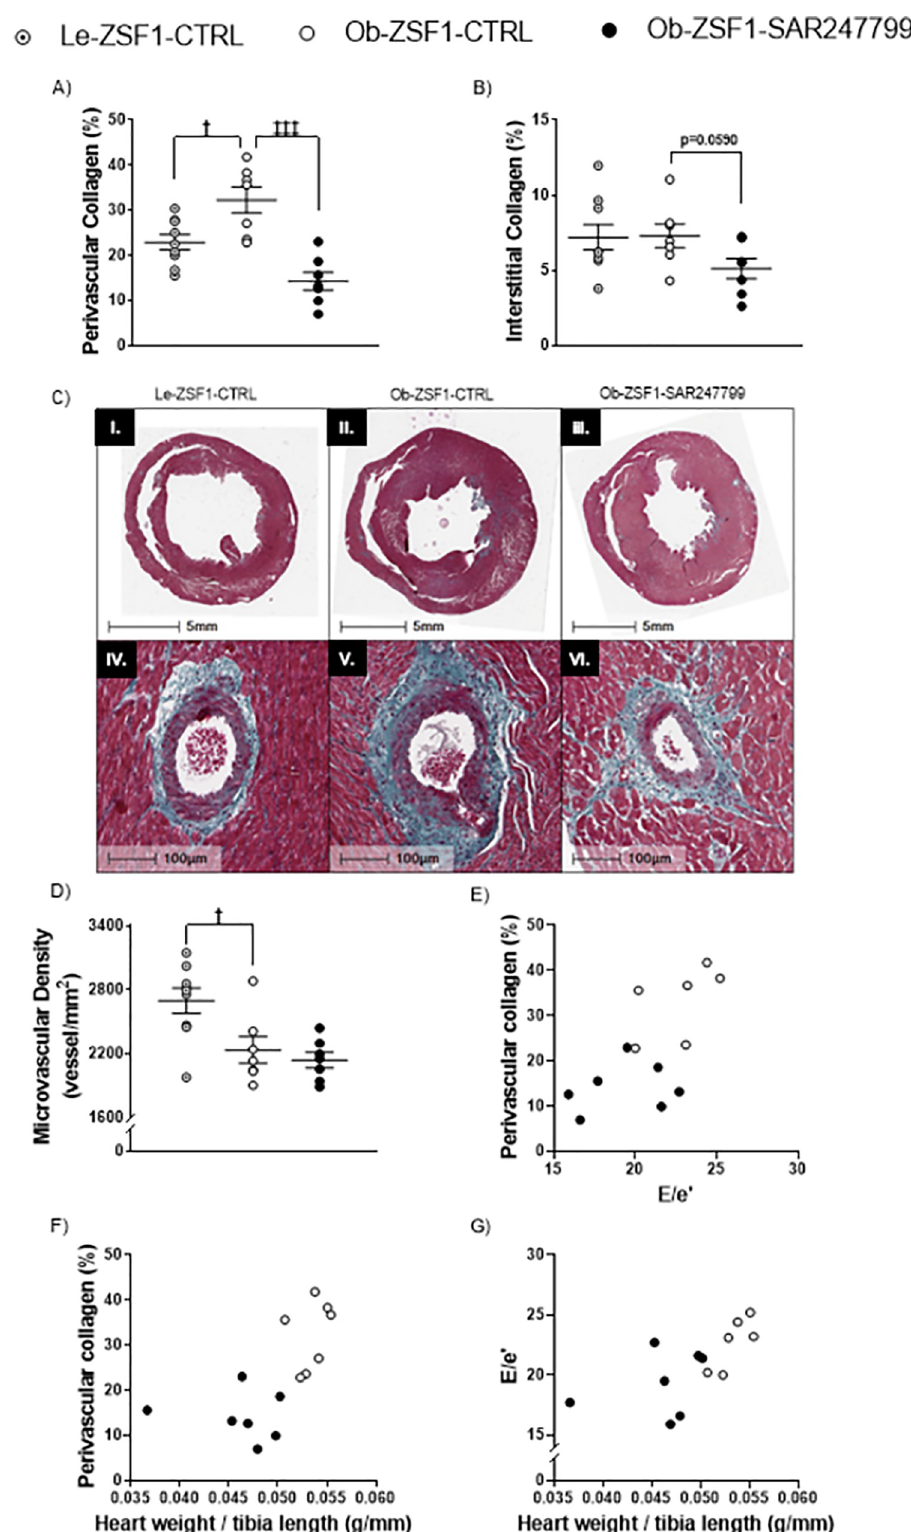
Fig 4. Cardiac fibrosis and microvascular density after 4 weeks of treatment and relationships between diastolic dysfunction, cardiac hypertrophy and fibrosis in aged ZSF1 rats. (A) perivascular collagen, (B) interstitial